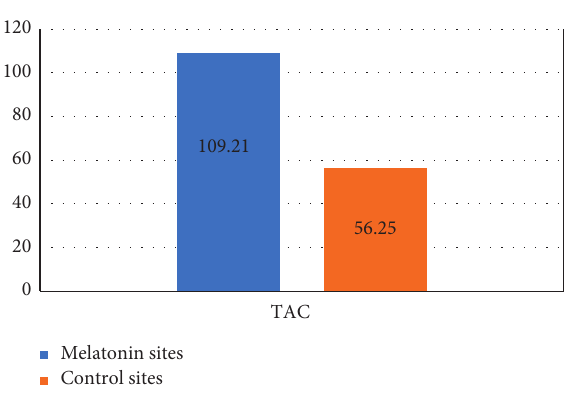
Figure 3: Bar chart of MMP-9 percent change in both